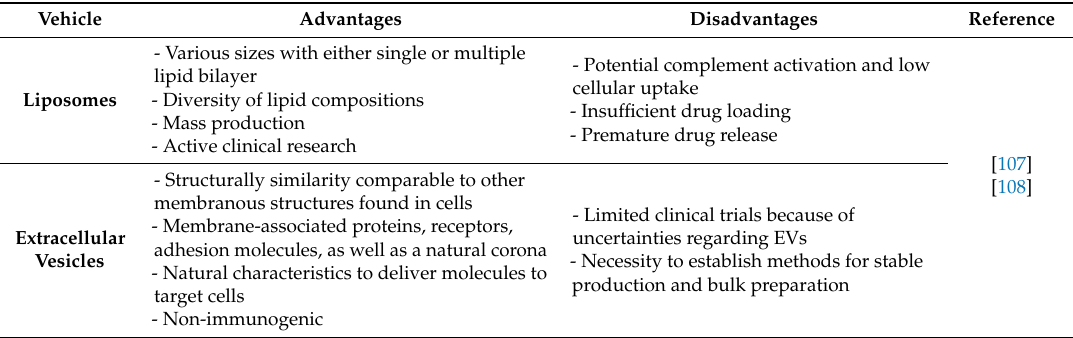
Table 3. Comparison of liposomes and extracellular vesicles